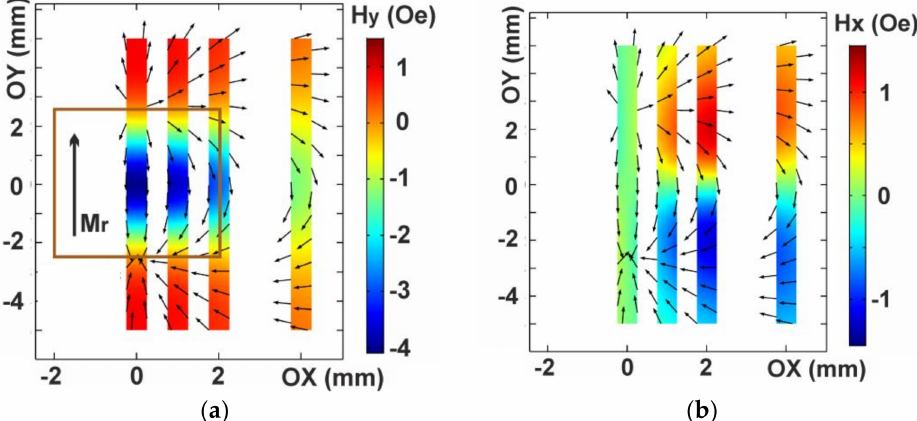
Figure 8. Stray magnetic fields distribution on the surface of the MI multilayered element for different positions of the magnetic composite sample placed at a distance of 1.2 mm from the surface of the MI element. Magnetic composite magnetization is directed along the OY axis: Hy stray magnetic field component along the long side of the MI element ( a ); Hx stray magnetic field component along the short side of the GMI element ( b ). Mr —the magnetization direction of the magnetic composite in XY